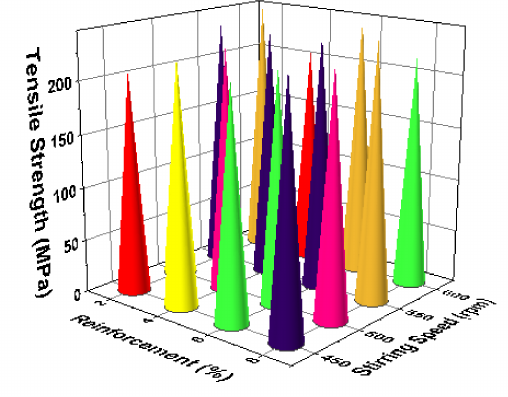
Figure 11. 3D bar plot: reinforcement vs. stirring.